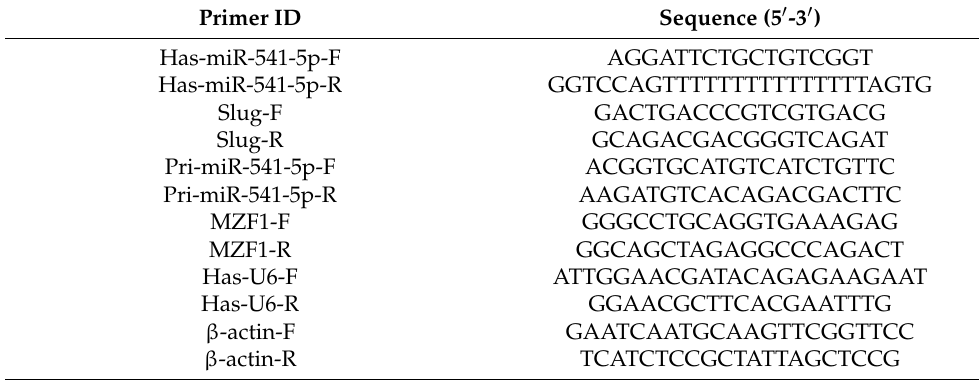
Table 1. RT-qPCR